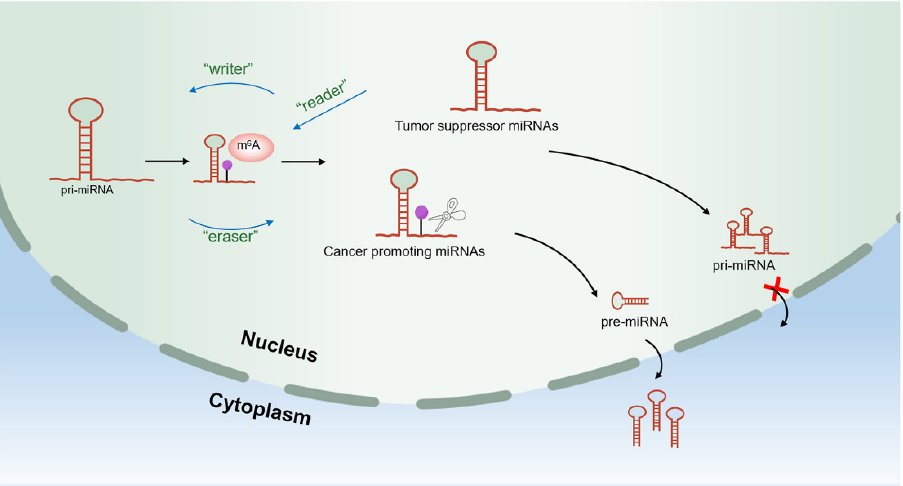
Figure 4. The m6A modification regulation of miRNAs in tumors. The m6A modification process of miRNA is coordinated by m6A writers, readers, and erasers and determines its maturation and expression. Purple circle indicates m6A modification performed by m6A writers at the pri-miRNA motif, which facilitates processing by associated proteases and favors the production of pre-miRNA. However, tumor suppressor miRNA cannot be efficiently labeled by m6A due to lack of m6A writers or readers, or over-processing by demethylases, which results in a large number of pri-miRNAs remaining in the nucleus and unable to undergo normal processing steps. On the contrary, oncogenic miRNA is more easily modified by m6A to promote its expression.